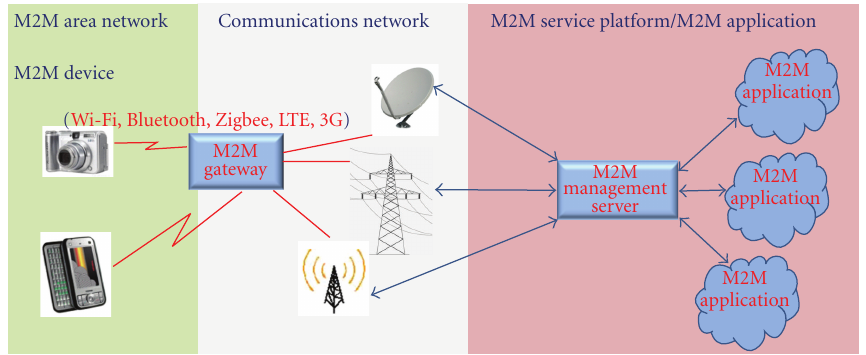
Figure 1: Architecture of M2M